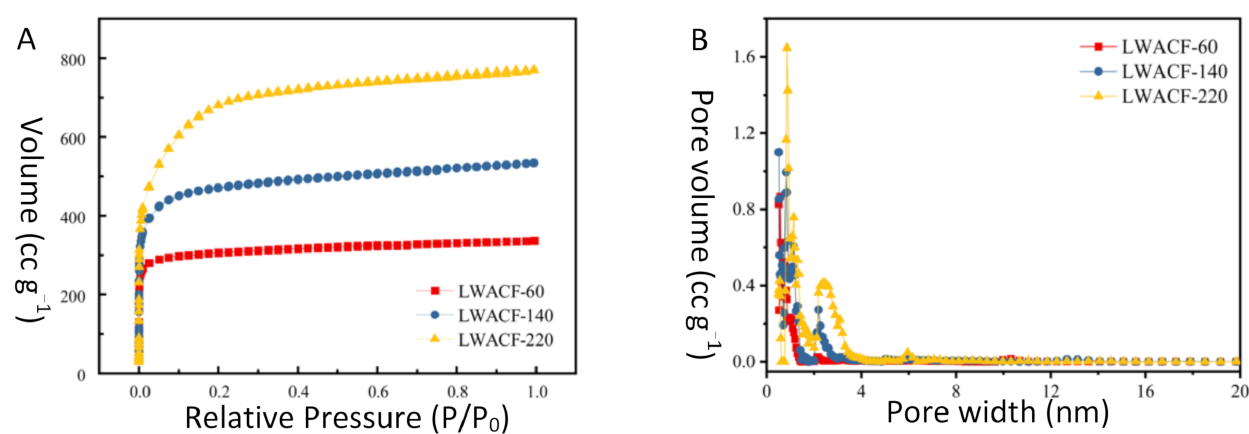
Figure 3. N 2 adsorption isotherm ( A ) and pore size distribution ( B ) of LWACF. Table 1. Pore structure parameters of LWACFs used for Cu 2+ adsorption property test. Samples